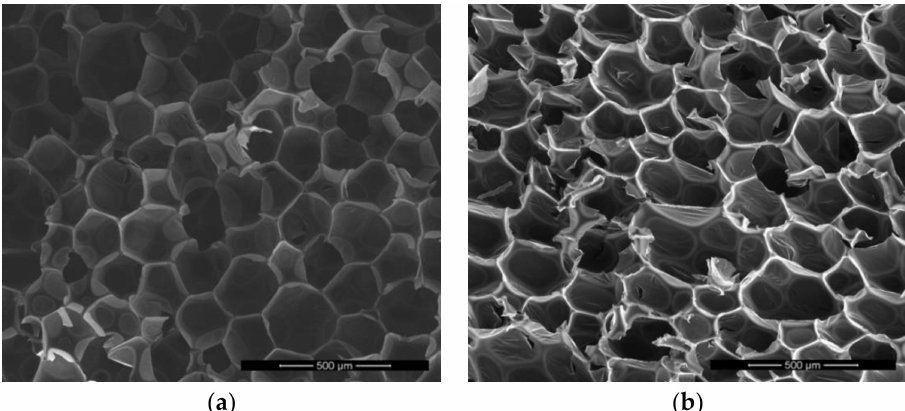
Figure 8. SEM micrographs of: ( a ) reference foam—G3.0, ( b ) foam modified by 0.5 Eq of